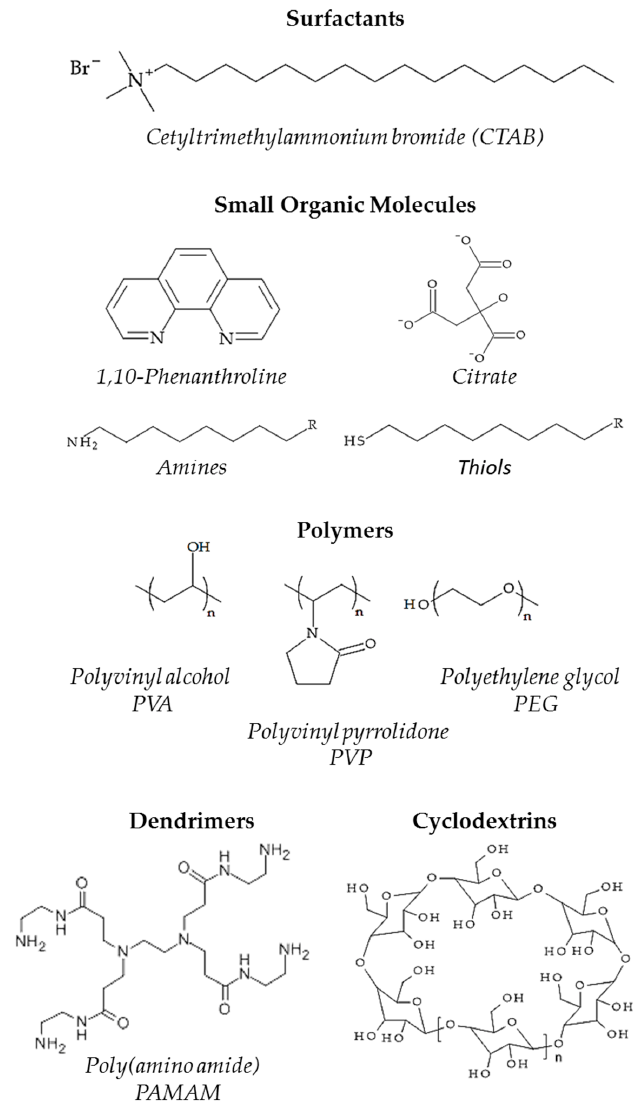
Figure 1. Representative capping agents used in metal nanoparticle synthesis.